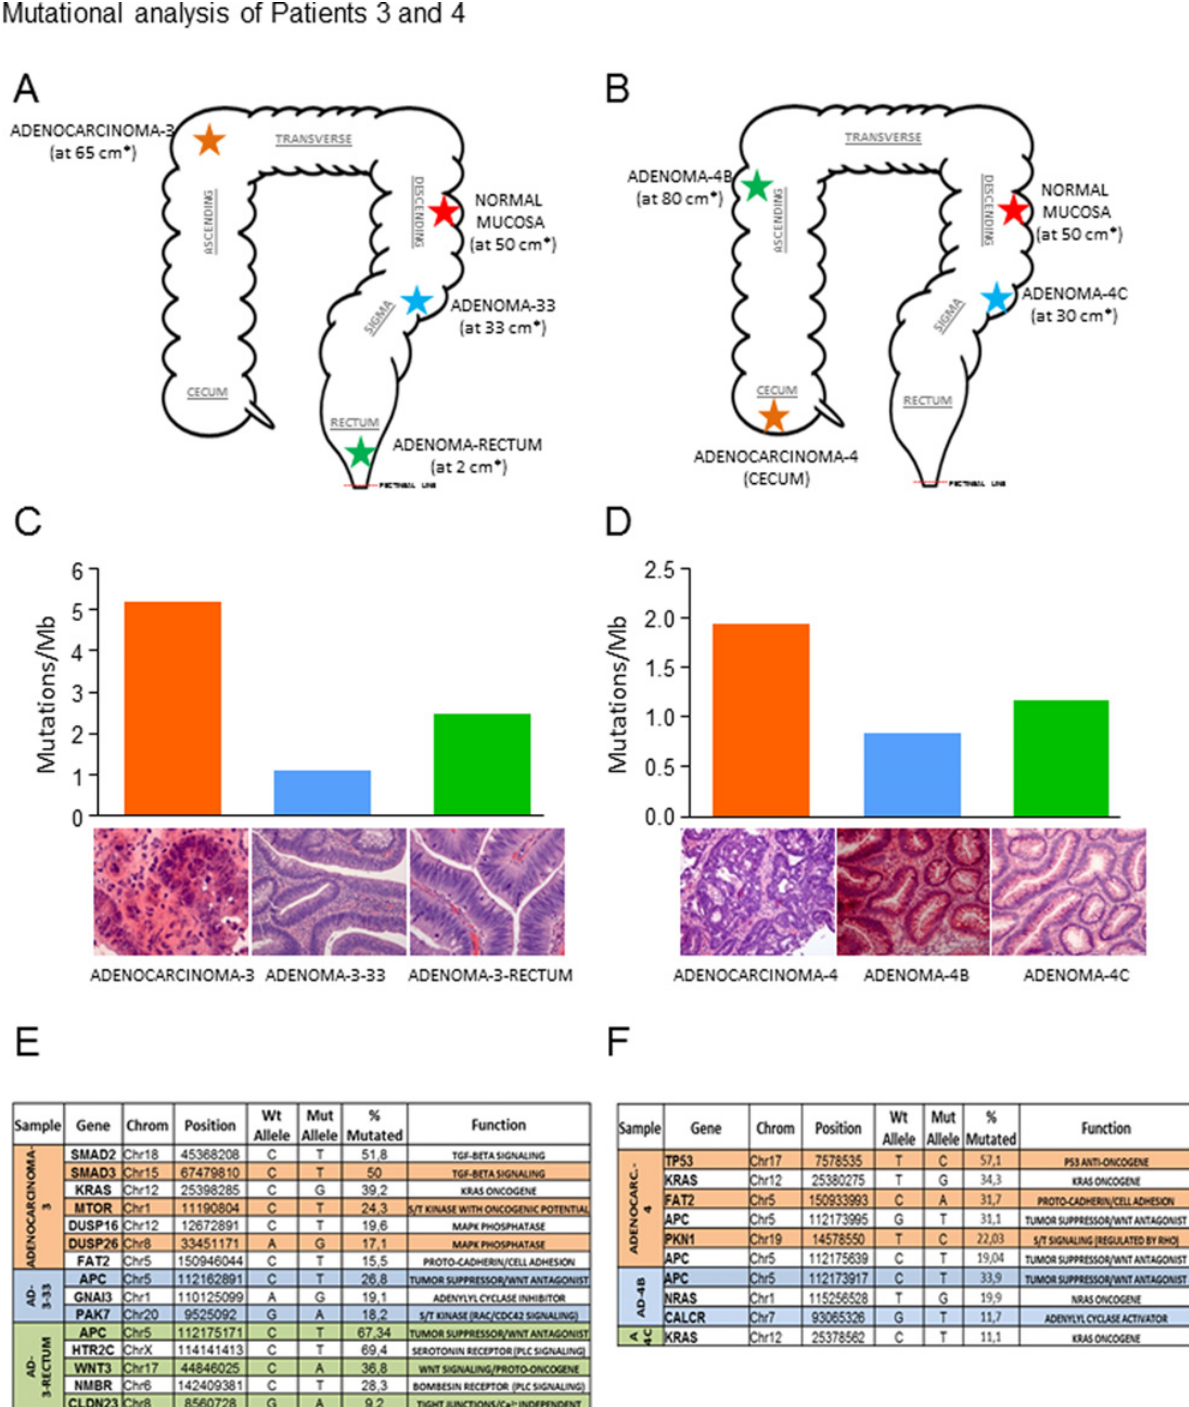
Fig 3. Mutation analyses of patients 3 and 4. Scheme showing an approximated representation of the location of each lesion analysed in patient-3 (A) and patient-4 (B). The distance ( * , in cms) from the pectineal line (red dots) is shown. C), D) Mutational index (number of mutations/Mb) found in the indicated sample from the primary NGS analysis. H&E pictures are representative of each lesion studied by NGS. Tables below show a selection of genes with oncogenic potential found mutated in the primary analyses of patient-3 (E) and patient 4 (F). Chrom: chromosome; % mutated: percentage of mutant nucleotide found in the corresponding gene within the same